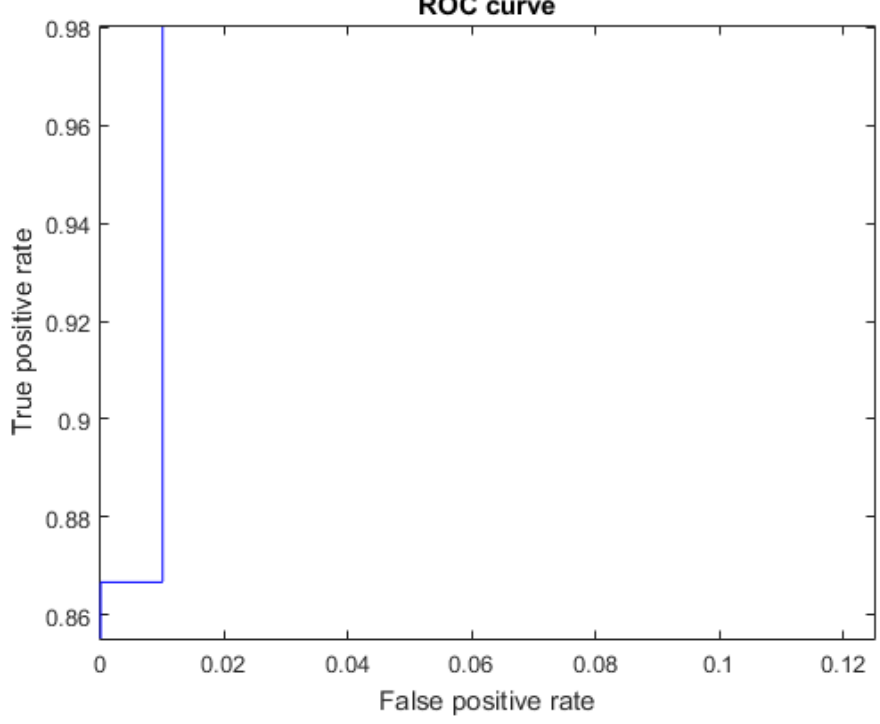
Figure 14. ROC curve for the letter F using Cartesian features, AUC = 0.9987.